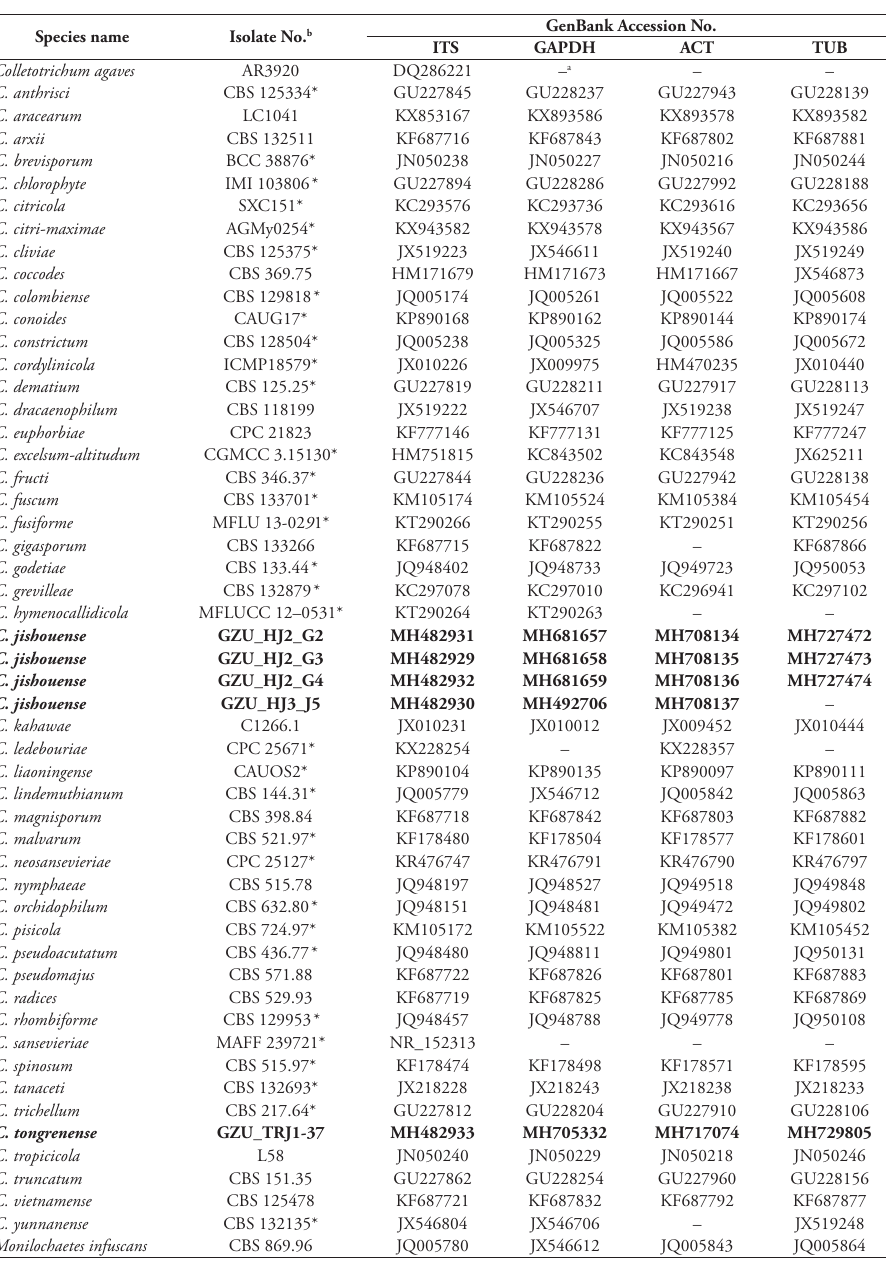
Table 1. Taxa used for phylogenetic analyses in the